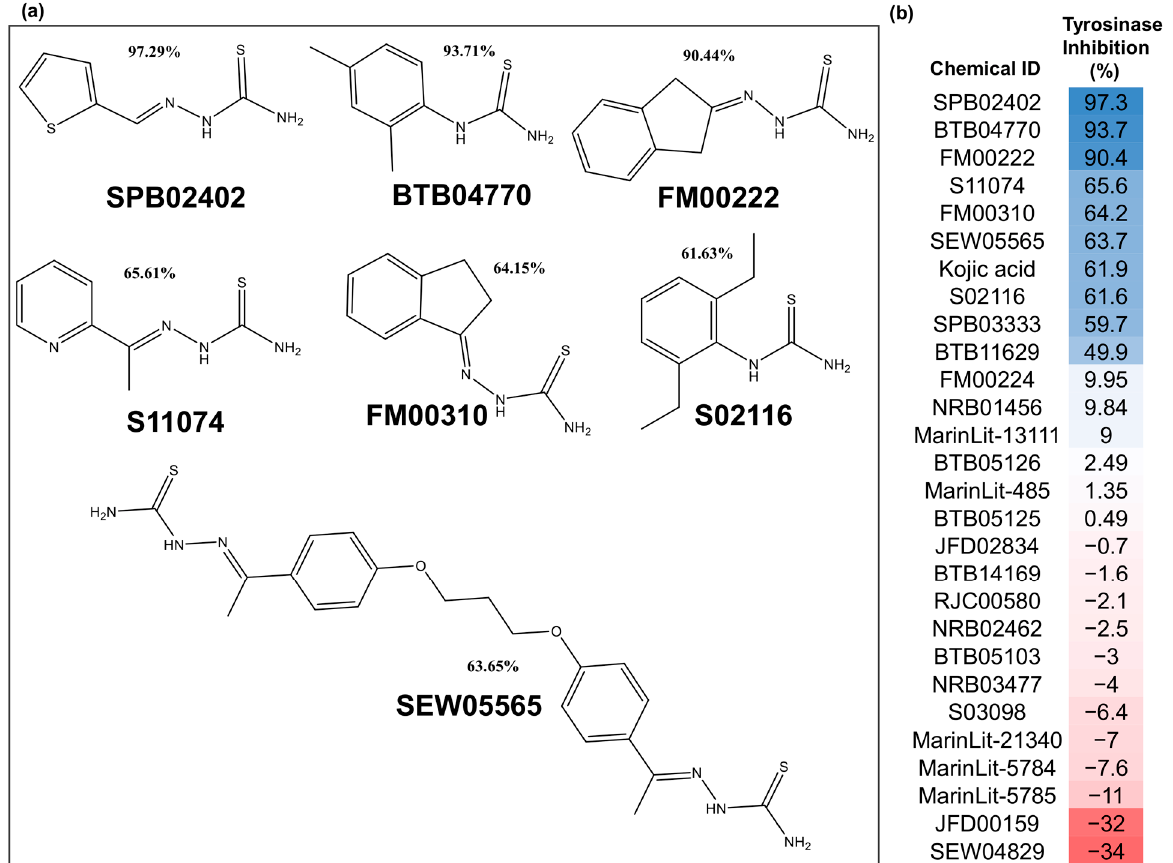
Figure 2. ( a ) Two-dimensional structures of the newly identified tyrosinase inhibitors found in the present study. ( b ) The relative tyrosinase inhibitory activities for 27 chemical compounds (1 mM) tested through the tyrosinase inhibition assay are shown. The tyrosinase inhibition percentage values are represented by a color gradient from blue (highest) to red (lowest). Table 1. The output values from TS-ensECBS, pharmacophore model, and tyrosinase inhibition assay for the seven newly identified inhibitors are given.